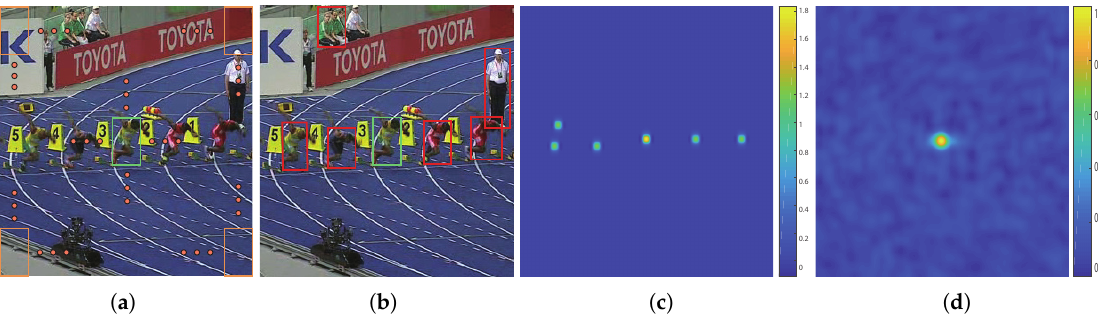
Figure 2. ( a ) Sliding sampled region of interest (ROI) centered on the target. ( b ) Obvious semantic distractors labeled in red bounding boxes. ( c ) Modulating factor in one training epoch. Note that the easy background is extremely suppressed, and the target and several selected distractors are reinforced. ( d ) Output regression map of the regression